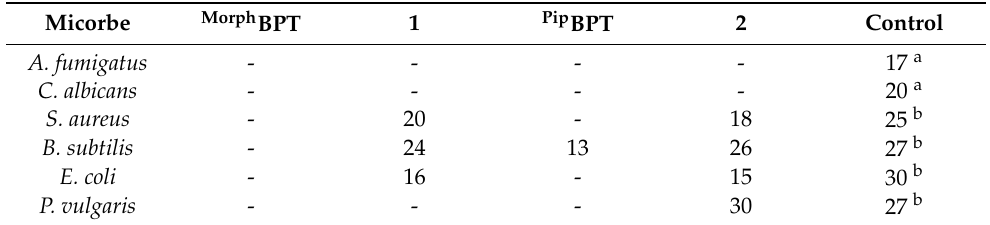
Table 5. Inhibition zone diameters of the studied compounds and control against different microbes a . Micorbe